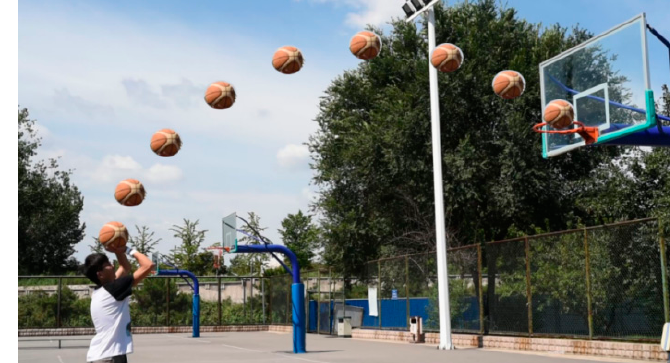
Figure 1. The movement of basketball when shooting.